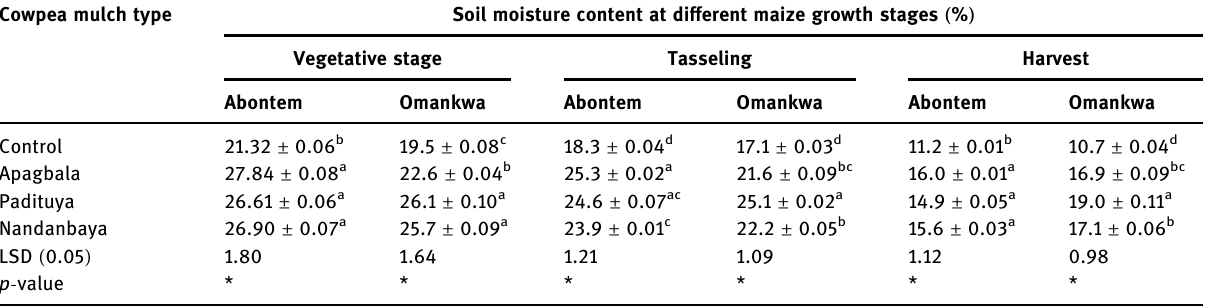
Table 3: Average soil moisture content a ff ected by cowpea living mulch types at di ff erent growth stages of two maize varieties Cowpea mulch type